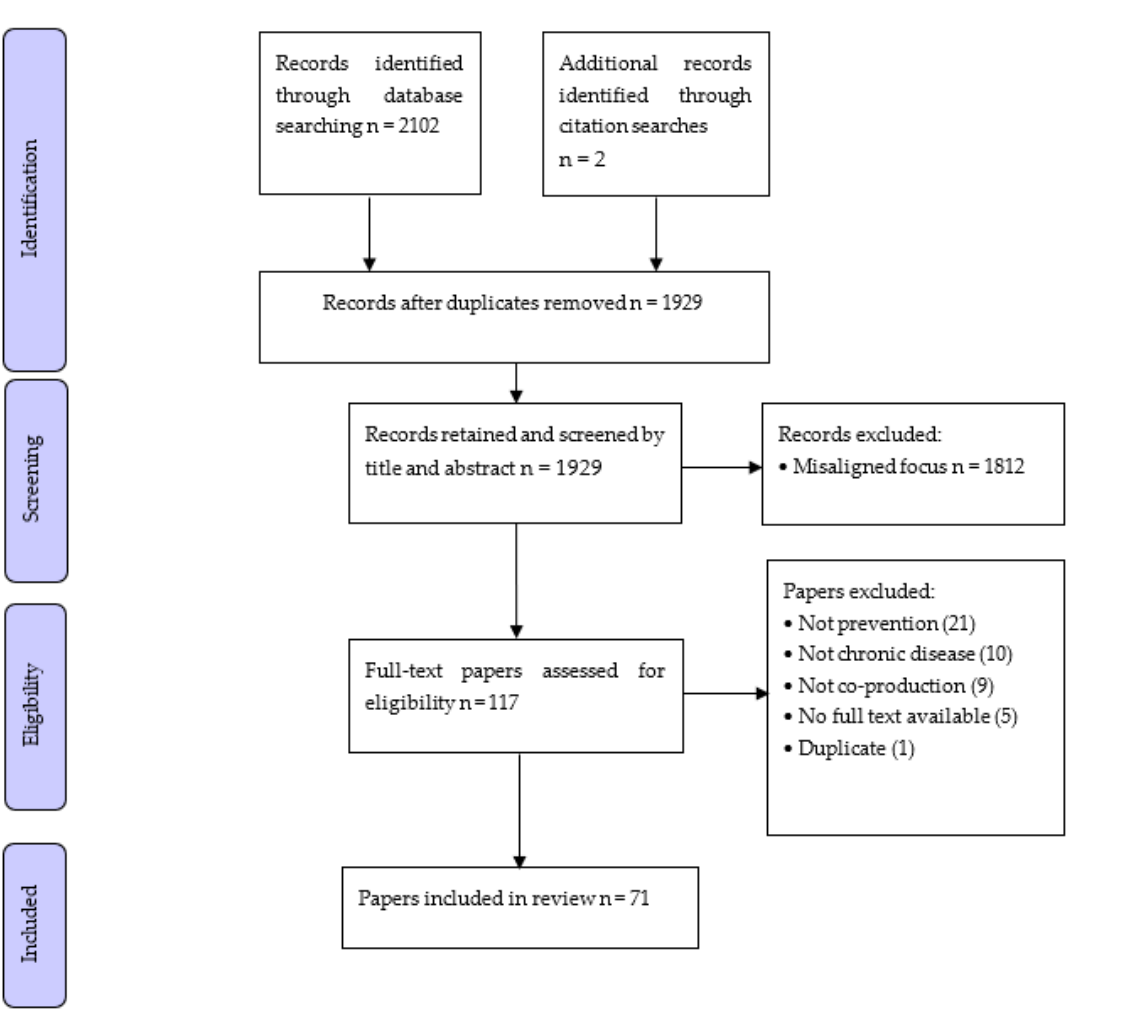
Figure 1. Flowchart of study selection and exclusion.